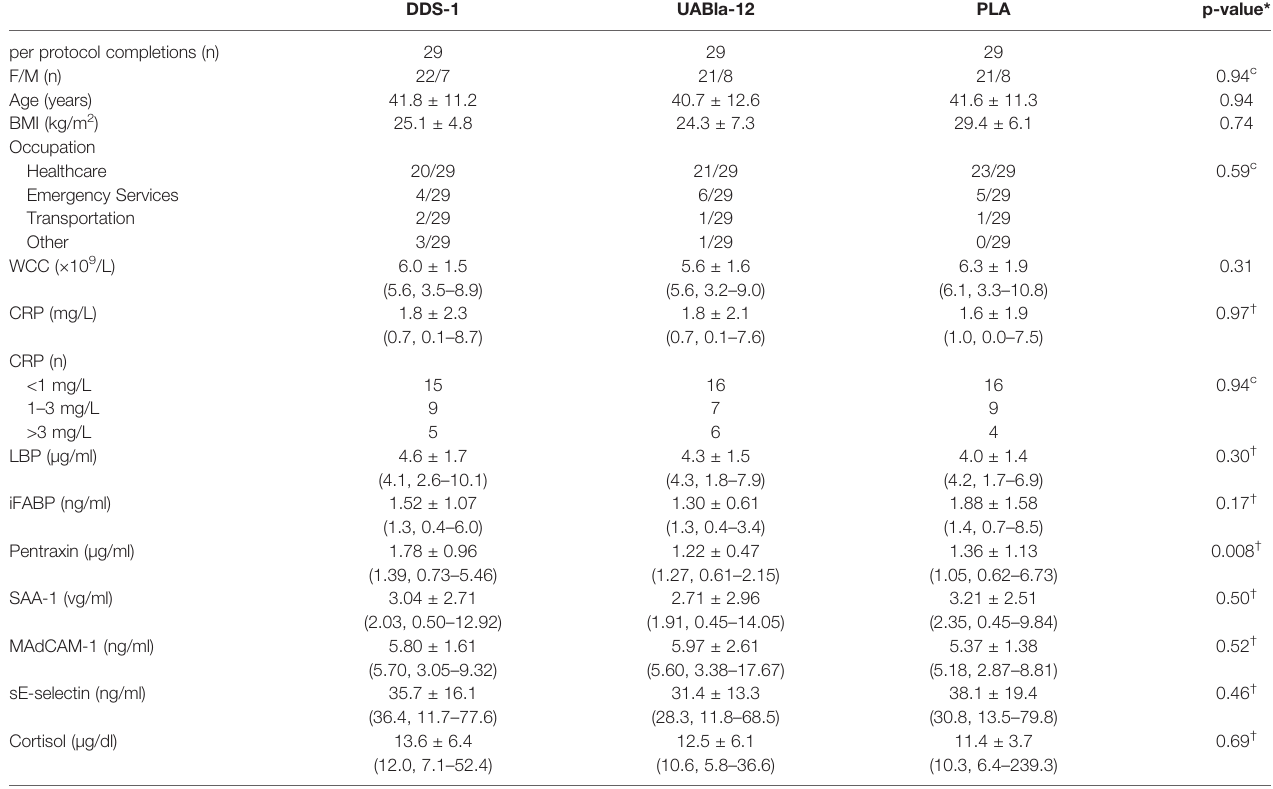
TABLE 1 | Baseline demographic measures between the